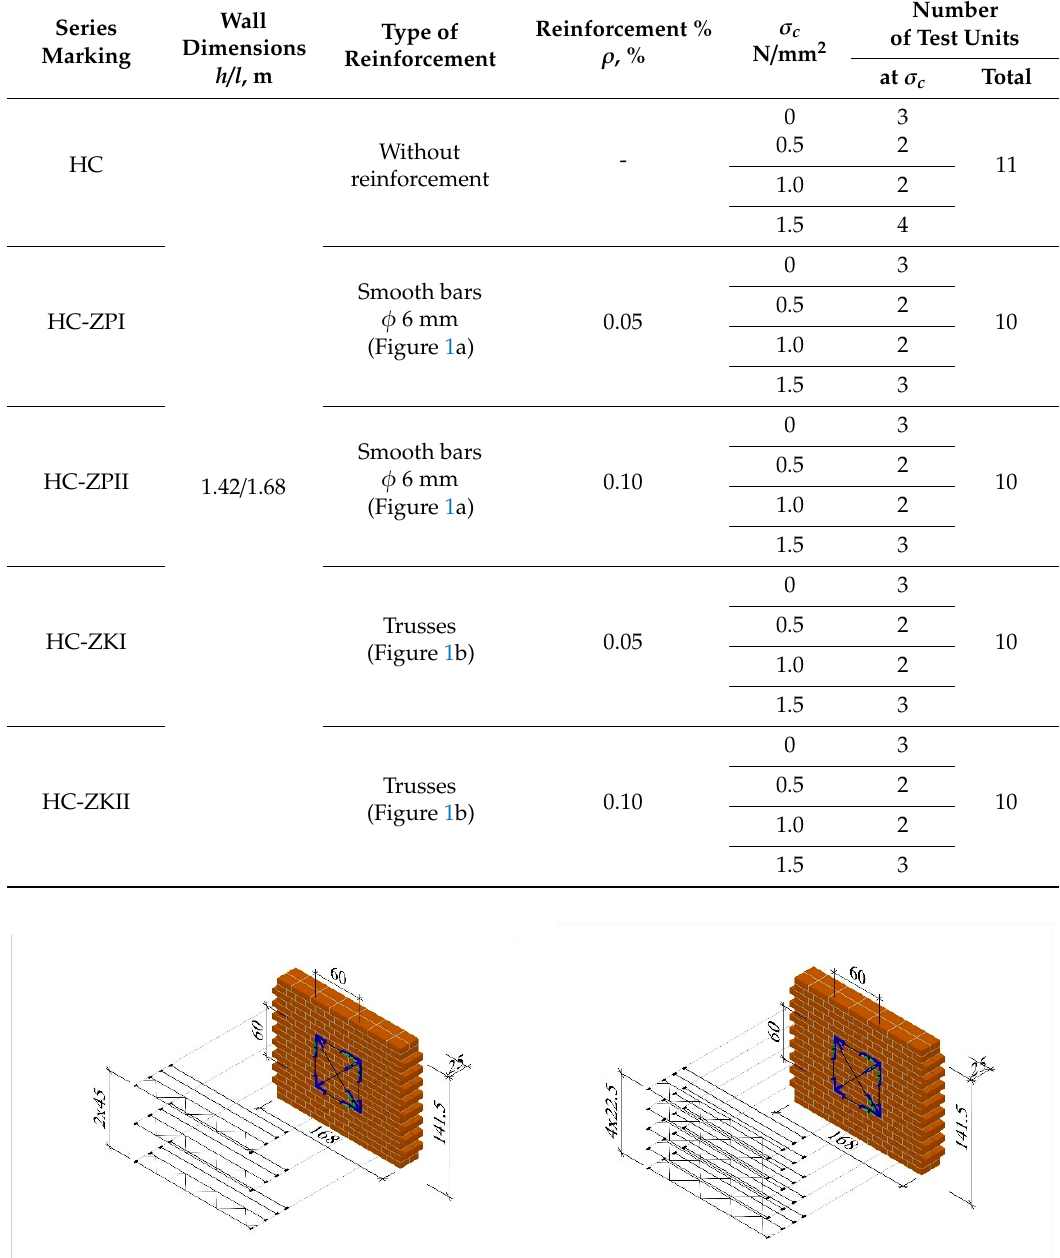
Table 1. Research programme for brick walls.